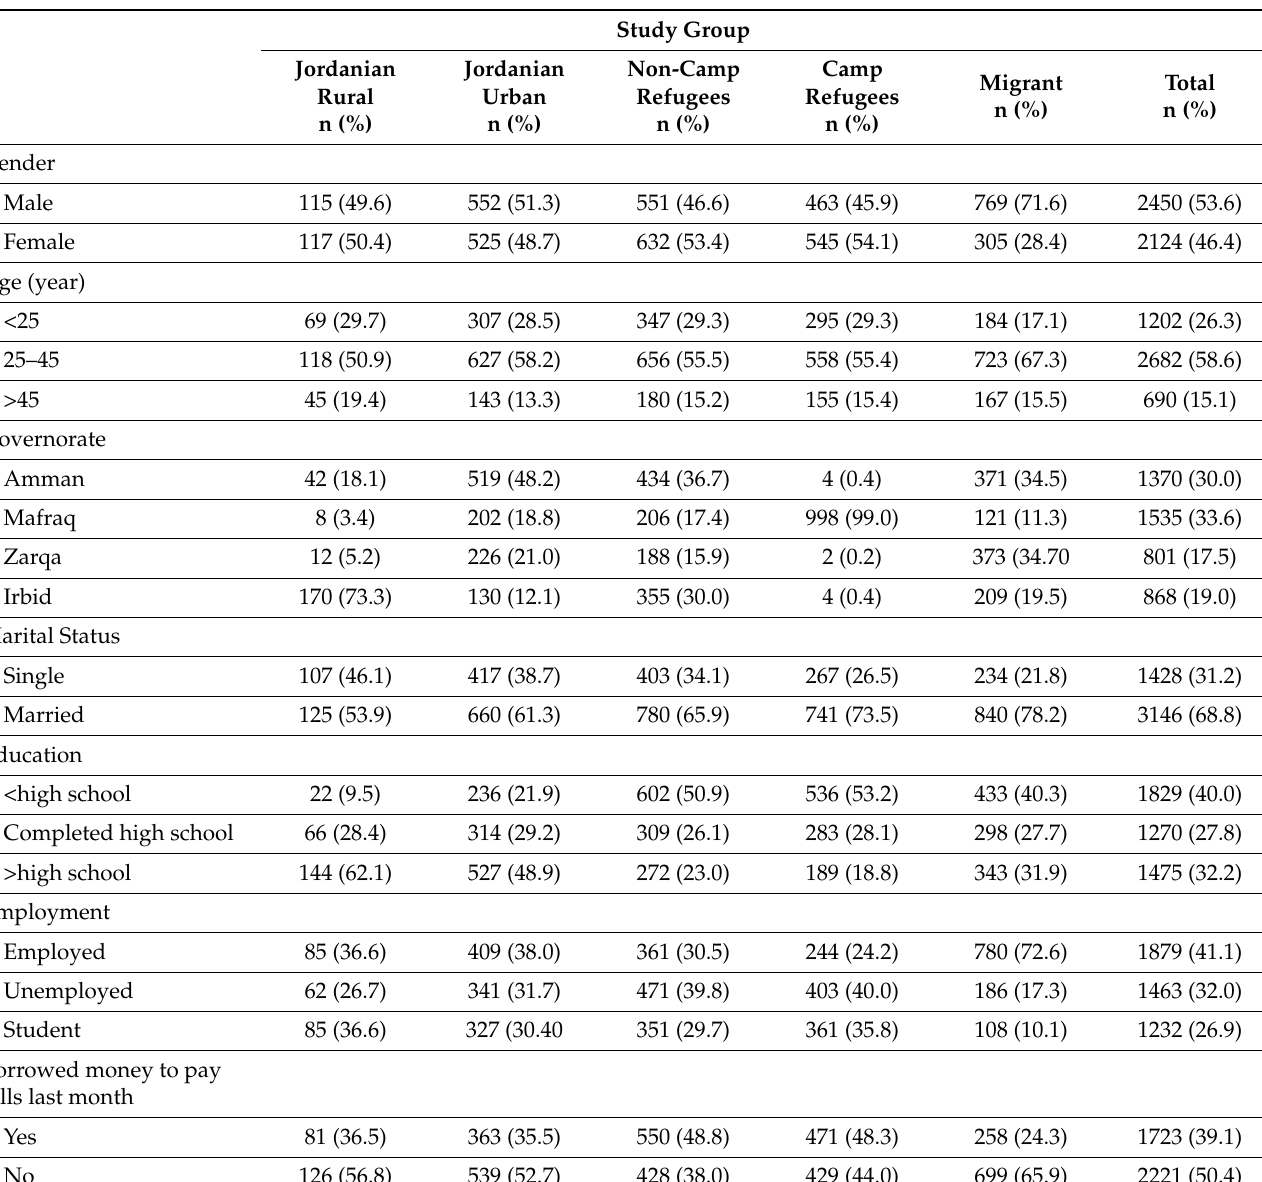
Table 1. The socio-demographic characteristics of Jordanians, refugees, and migrants. Study